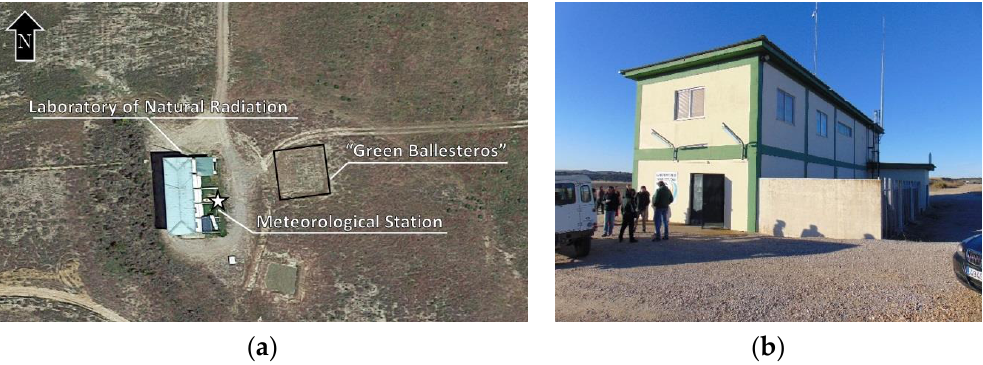
Figure 1. (a) Aerial view of the Laboratory of Natural Radiation (LNR) and surroundings where the intercomparison was developed; (b) Picture of LNR building taken from the south part. In the LNR ground floor, there are two rooms designed as radon chambers (Room1 and Room2) with approximately 45 m 3 volume each. Room1 has no direct connection to the exterior or any mixing